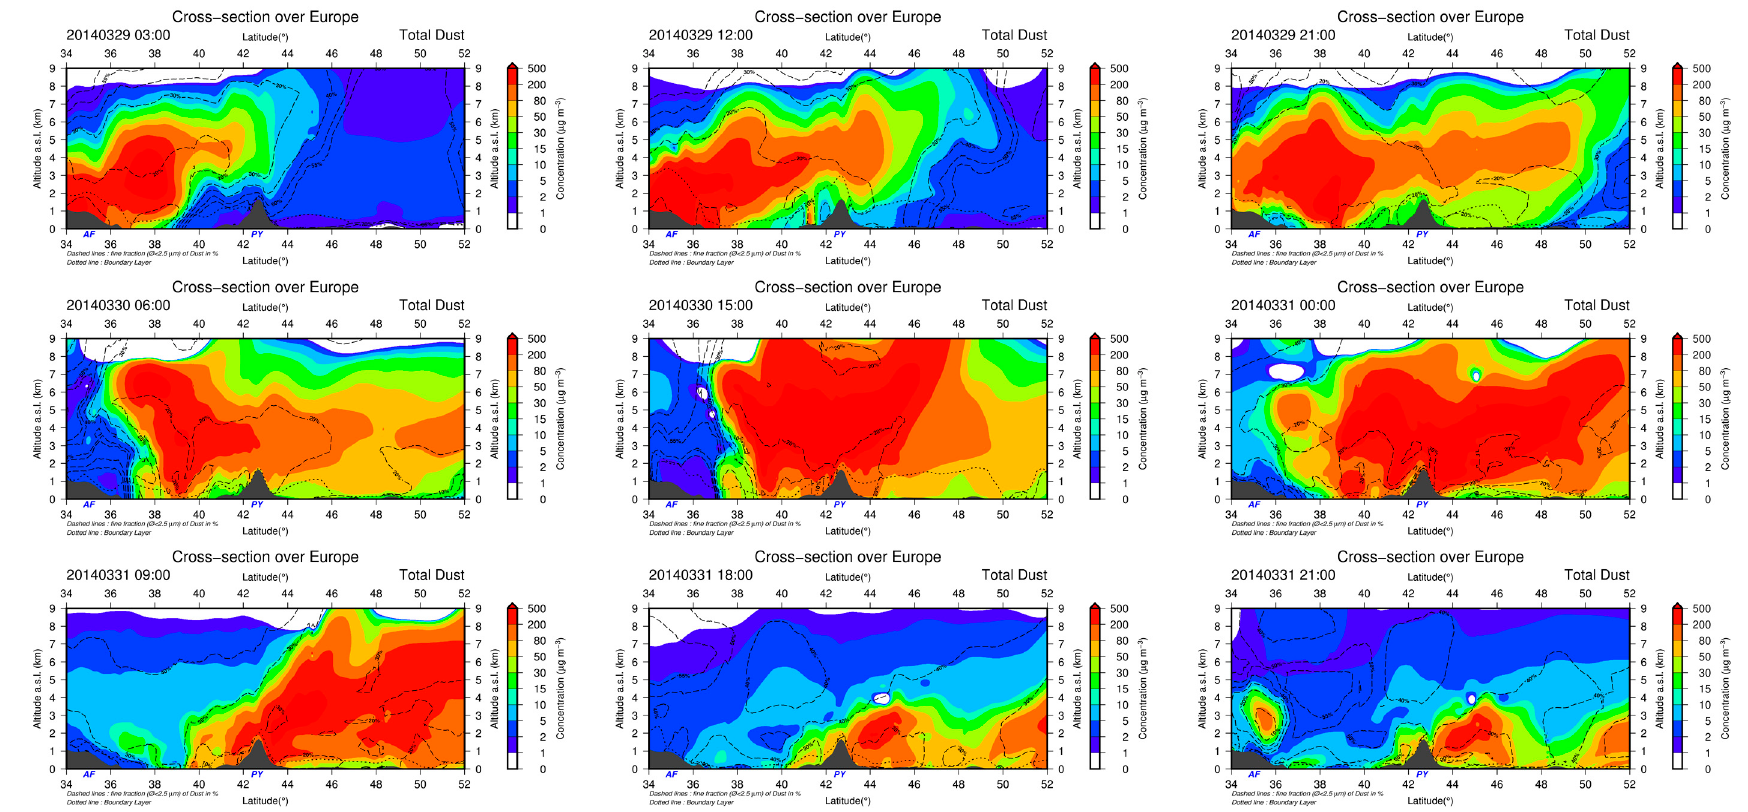
Figure 16. Vertical cross section of dust concentrations passing over the Pyrenees (PY) and starting from Africa (AF). The dashed lines represent the ratio PM 2.5 versus Total dust (particle diameter up to 40 µm).